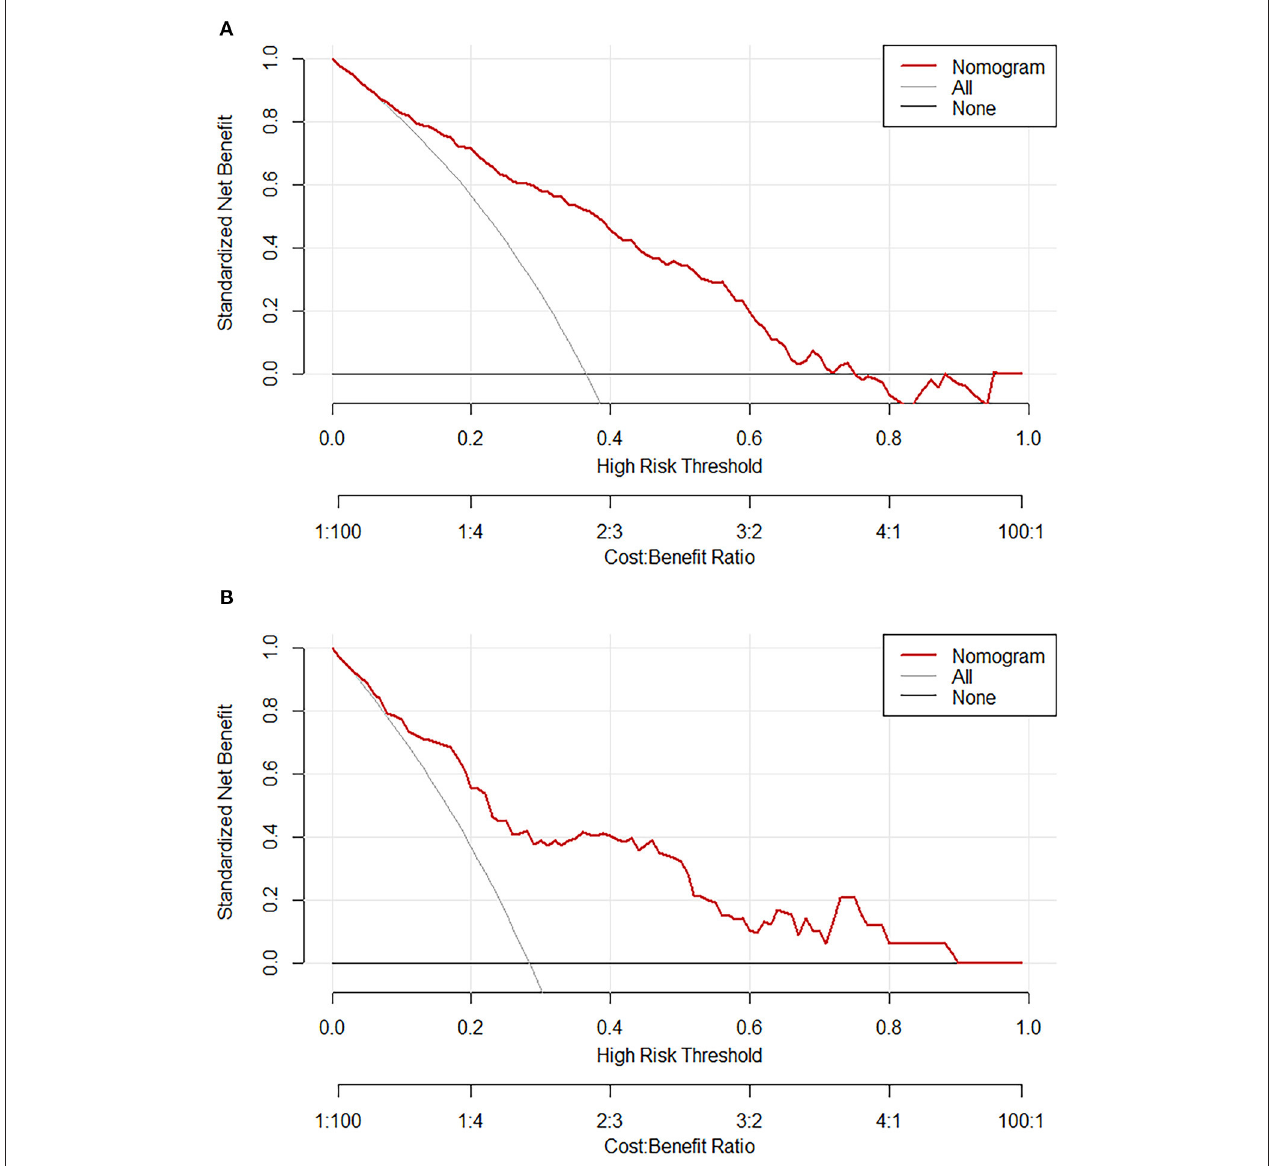
FIGURE 5 | Decision curve analysis of the nomogram in the primary cohort (A) and validation (B) cohort. The red line displays the net benefit of our model. The gray line assumes that all patients develop lower extremity deep vein thrombosis (DVT). The black line assumes that no patients develop lower extremity